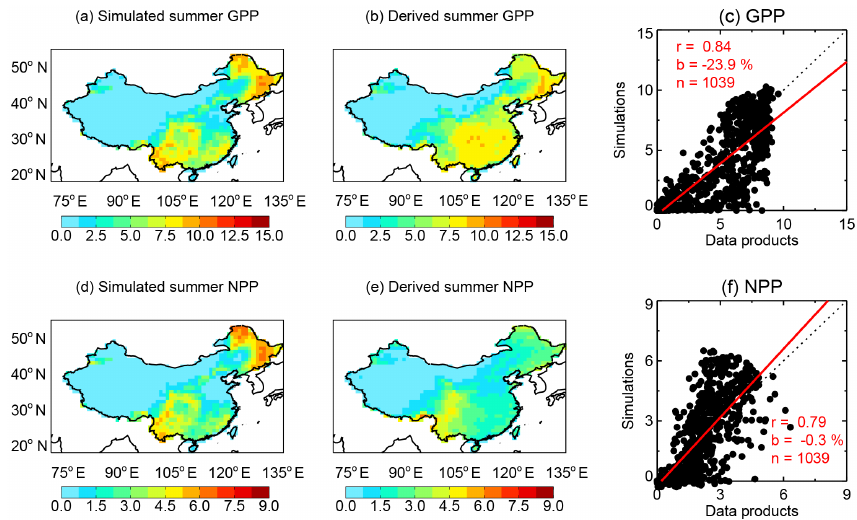
Figure 1. Evaluation of summertime carbon fluxes simulated with the YIBs model. Simulations are (a) GPP and (d) NPP from ALL010. Derived carbon fluxes are averaged for 2009–2011, with (b) GPP from the benchmark upscaling of flux tower data and (e) NPP from MODIS. The aerosol DFE is included in the simulation. The correlation coefficients ( r ), relative biases (b) , and number of 1 ◦ × 1 ◦ grid cells ( n ) for the comparisons are listed in the scatter plots ( c and f ). The dashed line represents the 1 : 1 ratio. The red line is the linear regression between simulations (predictand) and data products (predictor). The unit of GPP and NPP is gCm − 2 day − 1 .